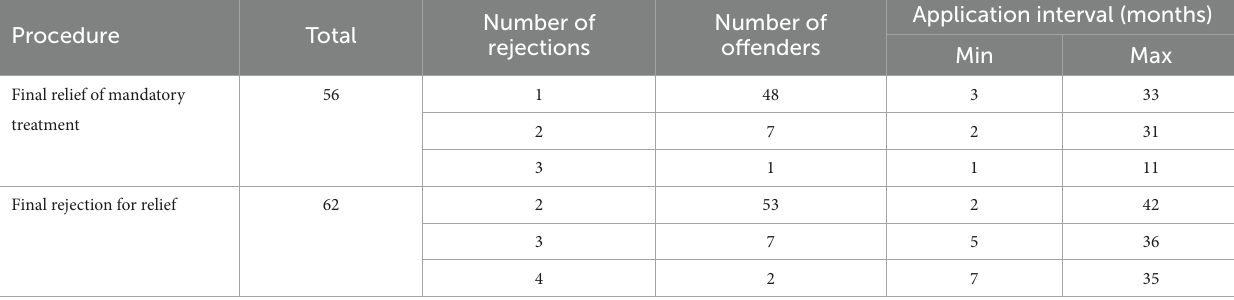
TABLE 3 Summary statistics of multiple applications for relief by the same offender ( N =